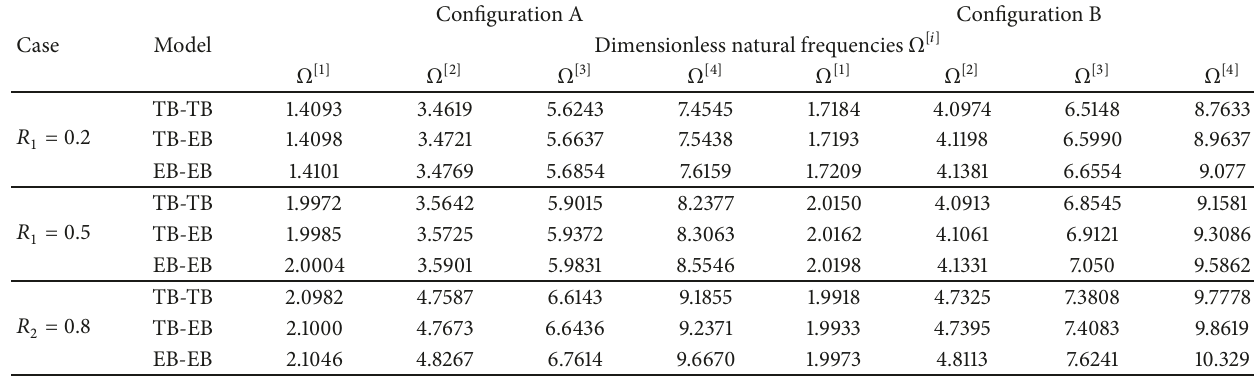
Table 6: The effects of the change of discontinuity point 𝑅 1 = 𝑥 1 /𝐿 in the dimensionless natural frequencies for a cantilever double span beam with variations of